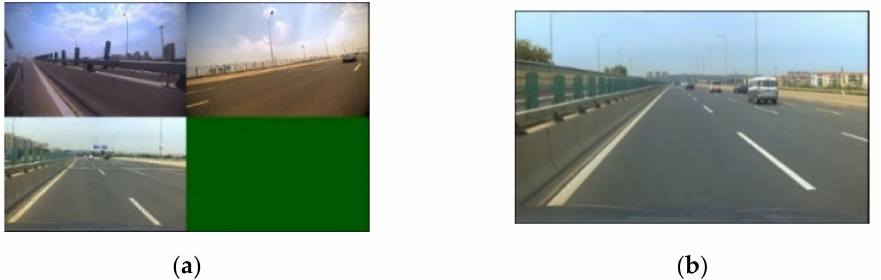
Figure 6. ( a ) Original video screenshot. The upper left indicates the left rear view of the ego-vehicle, the upper right indicates the right rear view, and the lower left indicates the front view; the rear view is not displayed. ( b ) Cropped screenshot of forward